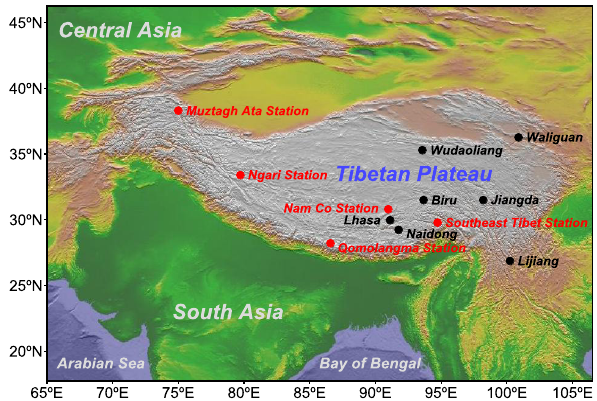
Figure 1. Map of the inorganic N wet deposition sampling sites in the TP. The red points indicate the five remote sampling sites of this study. The black points indicate the sampling sites from pre- vious records. Southeast Tibet Station is short for Southeast Tibet Observation and Research Station for the Alpine Environment, Chi- nese Academy of Sciences; Nam Co Station is short for Nam Co Monitoring and Research Station for Multisphere Interactions, Chi- nese Academy of Sciences; Qomolangma Station is short for Qo- molangma Atmospheric and Environmental Observation and Re- search Station, Chinese Academy of Sciences; Ngari Station is short for Ngari Desert Observation and Research Station; and Muztagh Ata Station is short for Muztagh Ata Westerly Observation and Re- search